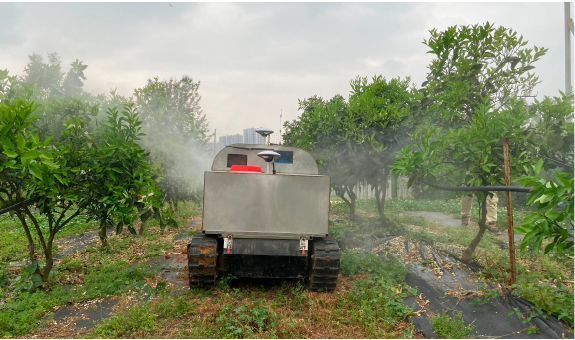
Figure 12. Field test of the spraying robot navigation system.